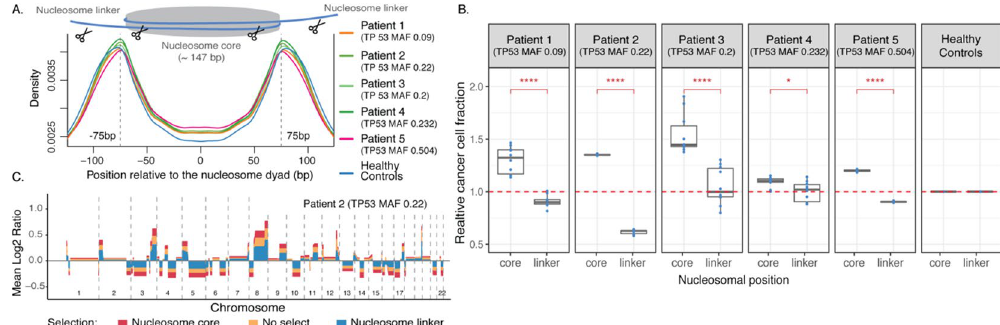
Figure 3. Location of DNA fragments relative to nucleosomal dyads. ( A ) The density of fragment start and end sites with respect to nucleosome dyads for patients and controls. The vertical lines are drawn at 75 bp downstream and upstream of the nucleosome center to signify the region of nucleosome core and linker. ( B ) Copy number aberration quantification of all technical replicates containing fragments starting and ending within nucleosome core or linker regions. ( C ) The average relative copy number values from the 10 replicates of patient 2. The different colors indicate results from using fragments that start and end within nucleosome core region, and fragments that start and end within nucleosome linker region as well as all fragments with no